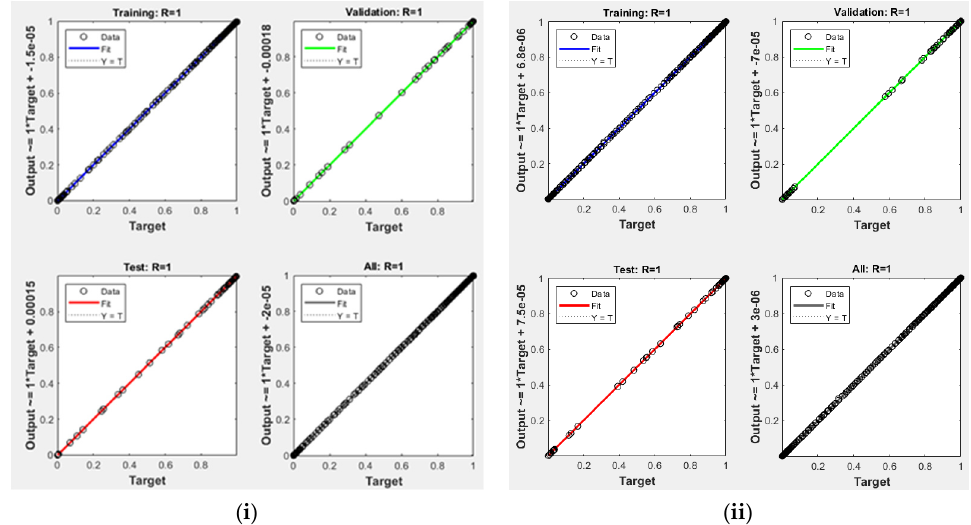
Polymers 2022 , 14 , 2638 Figure 4. Regression of training, validation, and test plots for the selected ( i ) AN7-A, ( ii ) AN7-B.